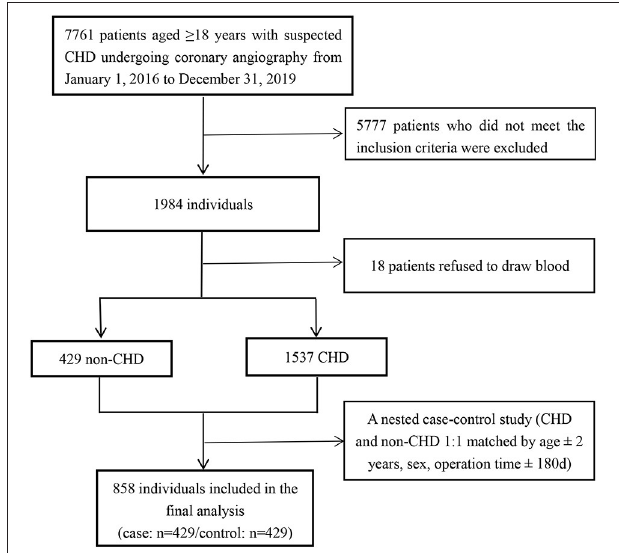
FIGURE 1 | Flow chart of study